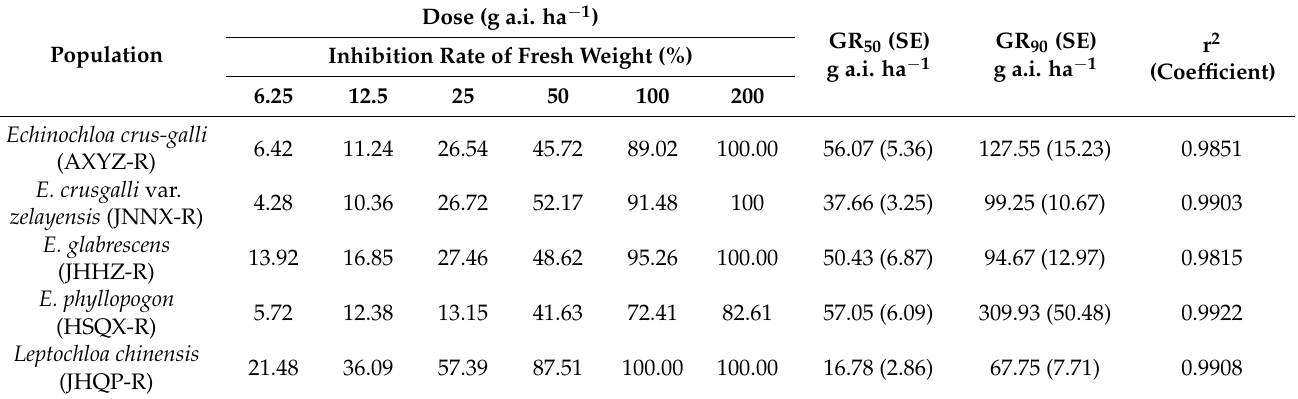
Table 4. Effect of Glyamifop on common herbicide-resistant gramineae weeds in the paddy field.